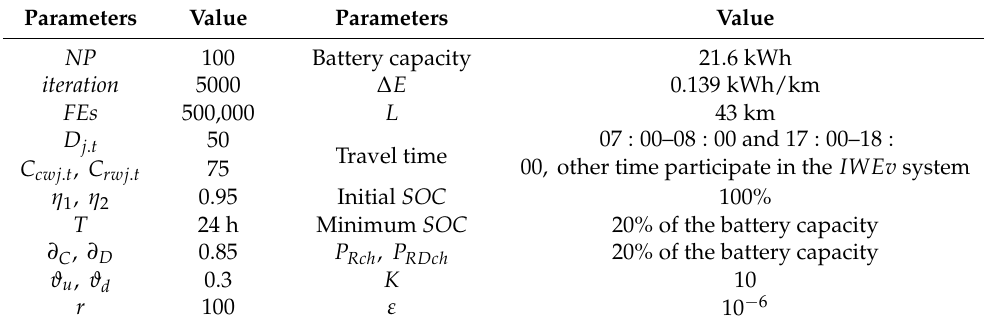
Table 5. System and EV parameter